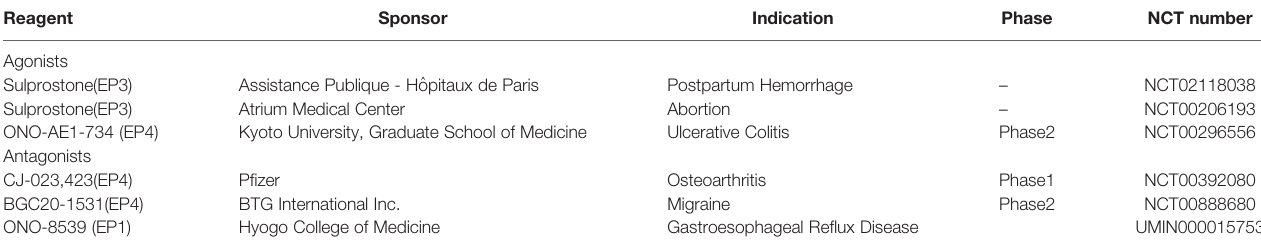
TABLE 2 | Clinical trials of EP receptors agonists/antagonists. Reagent Agonists Sulprostone(EP3)